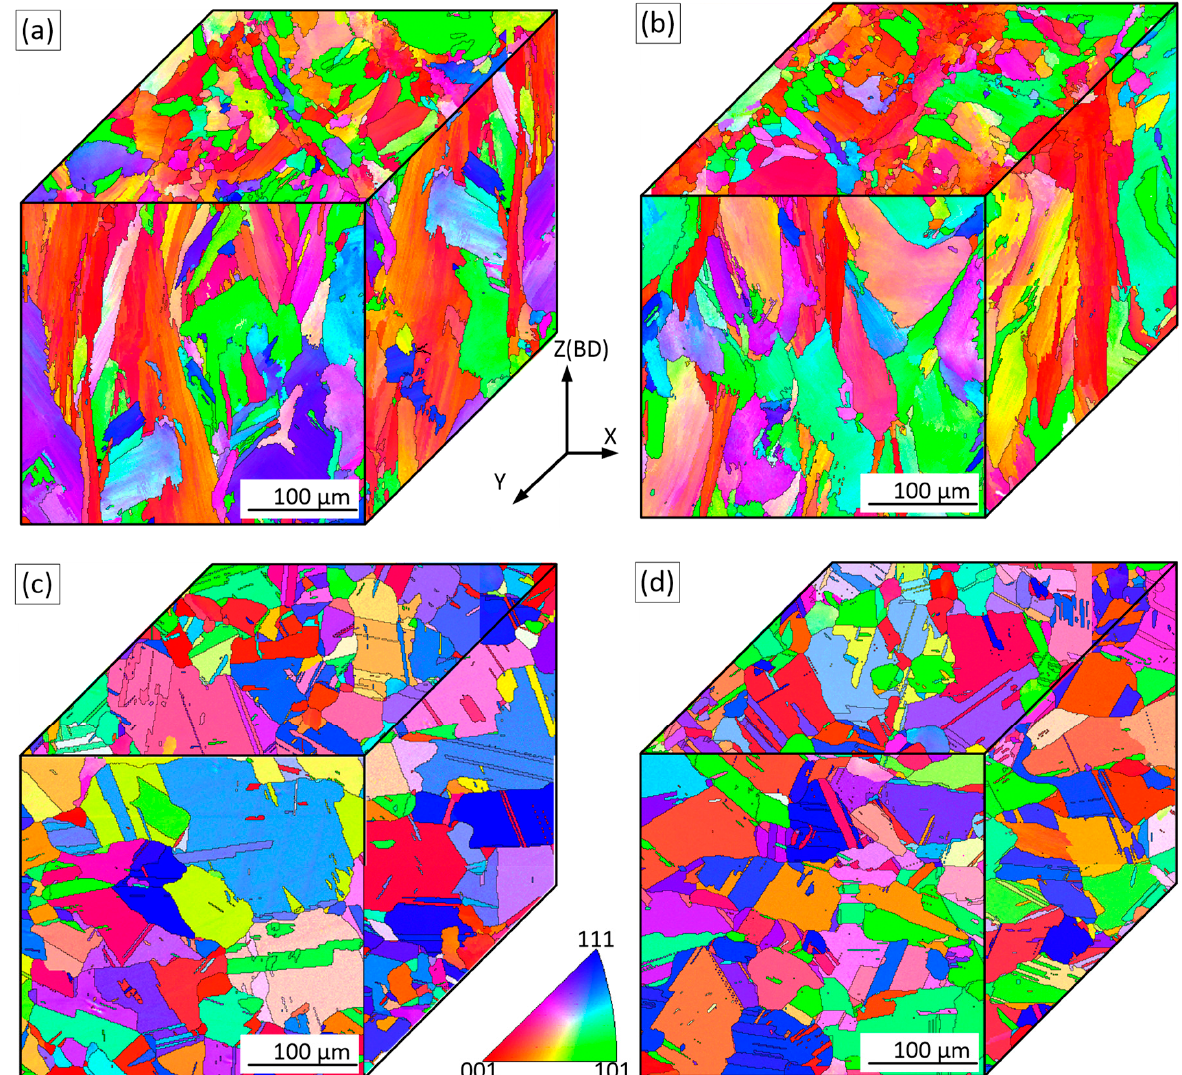
Figure 9. Orientation image microscopy (OIM) maps for ZX and XY planes: ( a , b ) after SR treatment; ( c , d ) after ST treatment; ( a , c ) Alloy 1 and ( b , d ) Alloy 2.